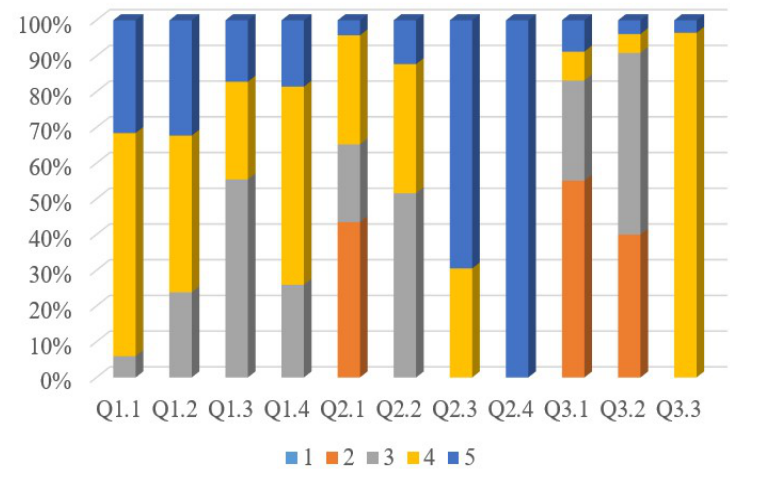
Figure 19. Evaluation of survey